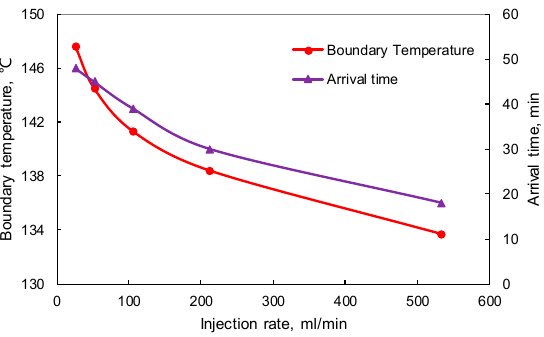
Figure 16. The time of temperature drop front arriving at the granite jacket boundary and the stable boundary temperature at different injection rates.